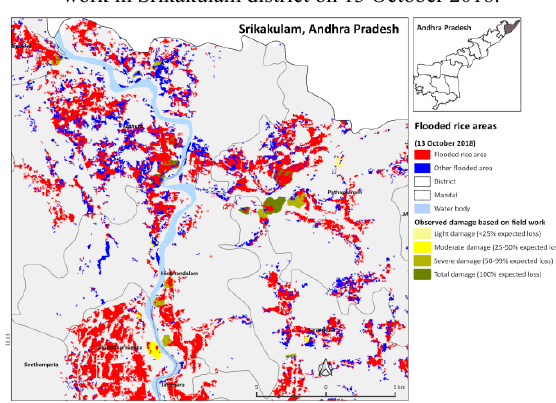
Figure 9. The observed rice crop damaged area based on field work in Srikakulam district on 13 October 2018.